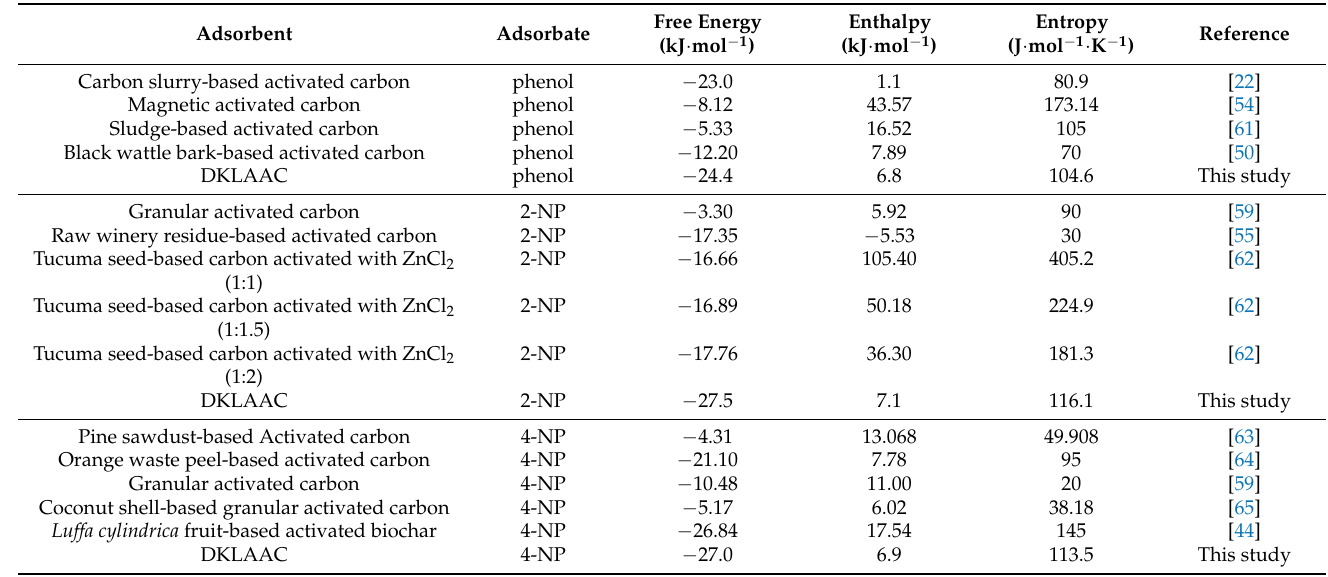
Table 4. Comparison of thermodynamic parameters of different activated carbons with DKLAAC for the removal of phenol and NPs as reported in the literature.